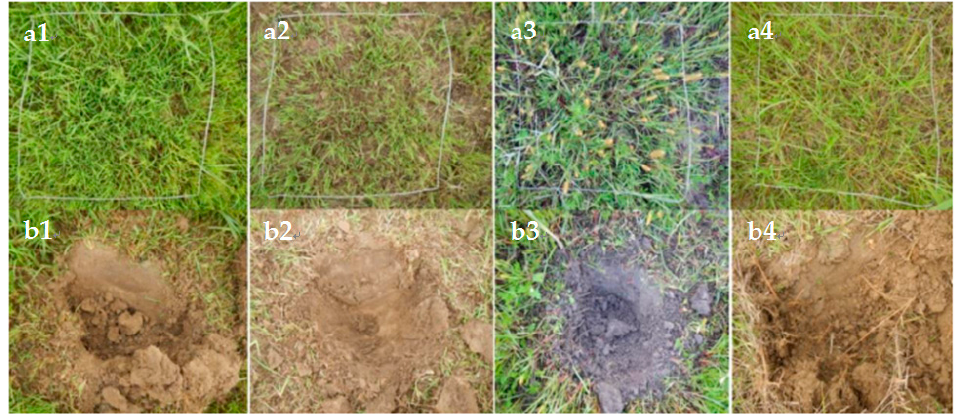
Figure 10. The field sampling pictures of the grassland in 2017. ( a1 )–( a4 ) the condition of grass coverage in sampling points; ( b1 )–( b4 ) the soil salinity of the corresponding sampling points.